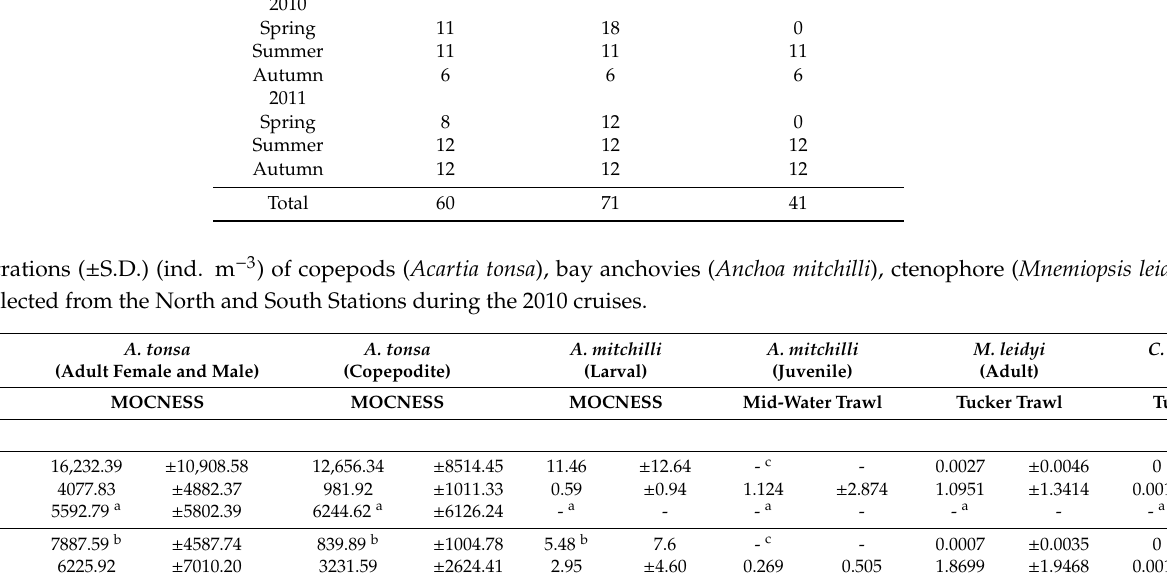
Table A2. The numbers of MOCNESS net tows, Tucker Trawls, and mid-water trawls conducted during each cruise.